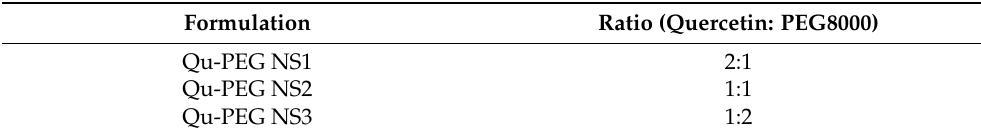
Table 1. The composition ratio of nanosuspension